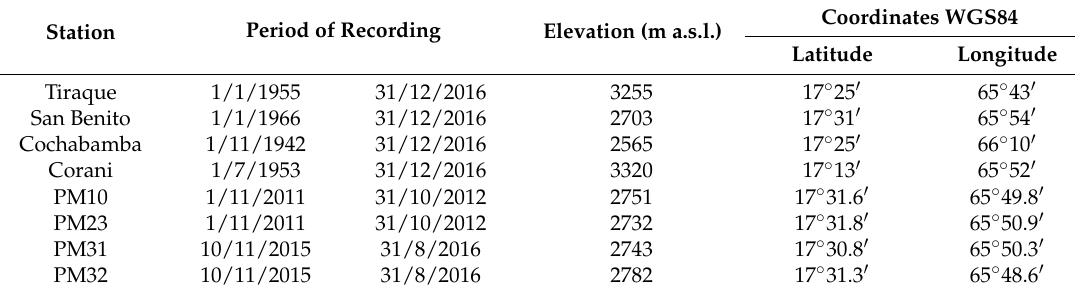
Table 1. Recording time interval of the selected meteorological stations and monitoring